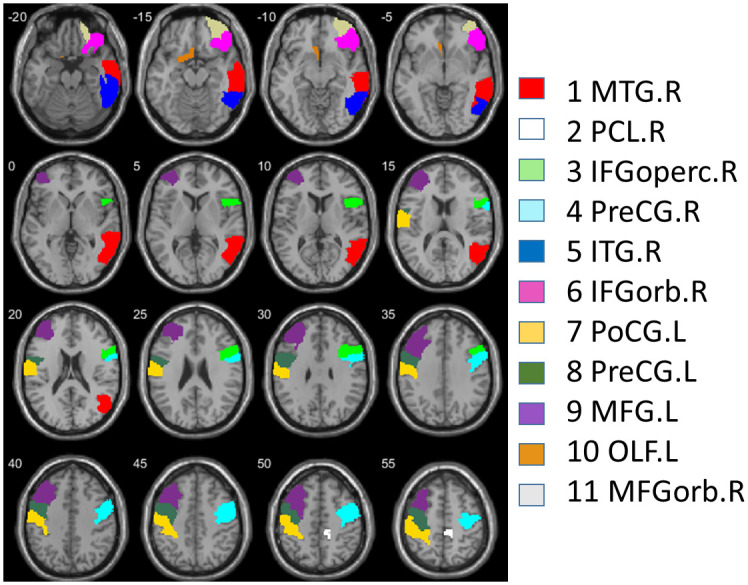
Horizontal slices of AAL areas with different GMV between groups, in the order of 1 to 11, following statistical significance.Z coordinates are shown in mm distance from the anterior-posterior commissure. The right side of the image corresponds to the right side of the brain.